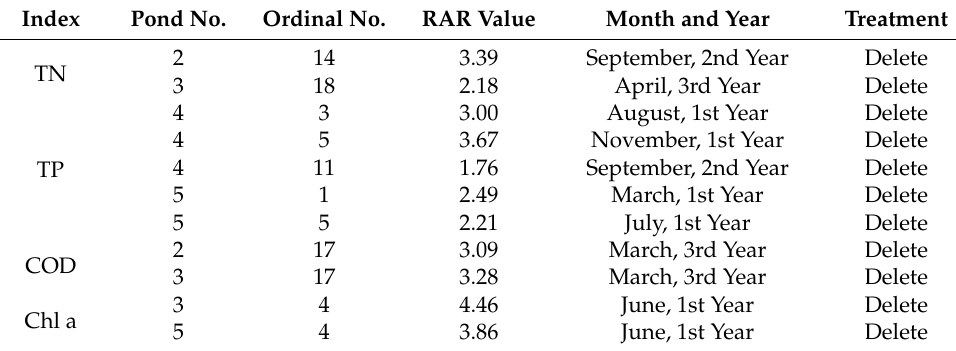
Table A3. Extreme RAR values of TN, TP, COD, and Chl a tested by boxplots in SPSS. Index Pond No. Ordinal No.